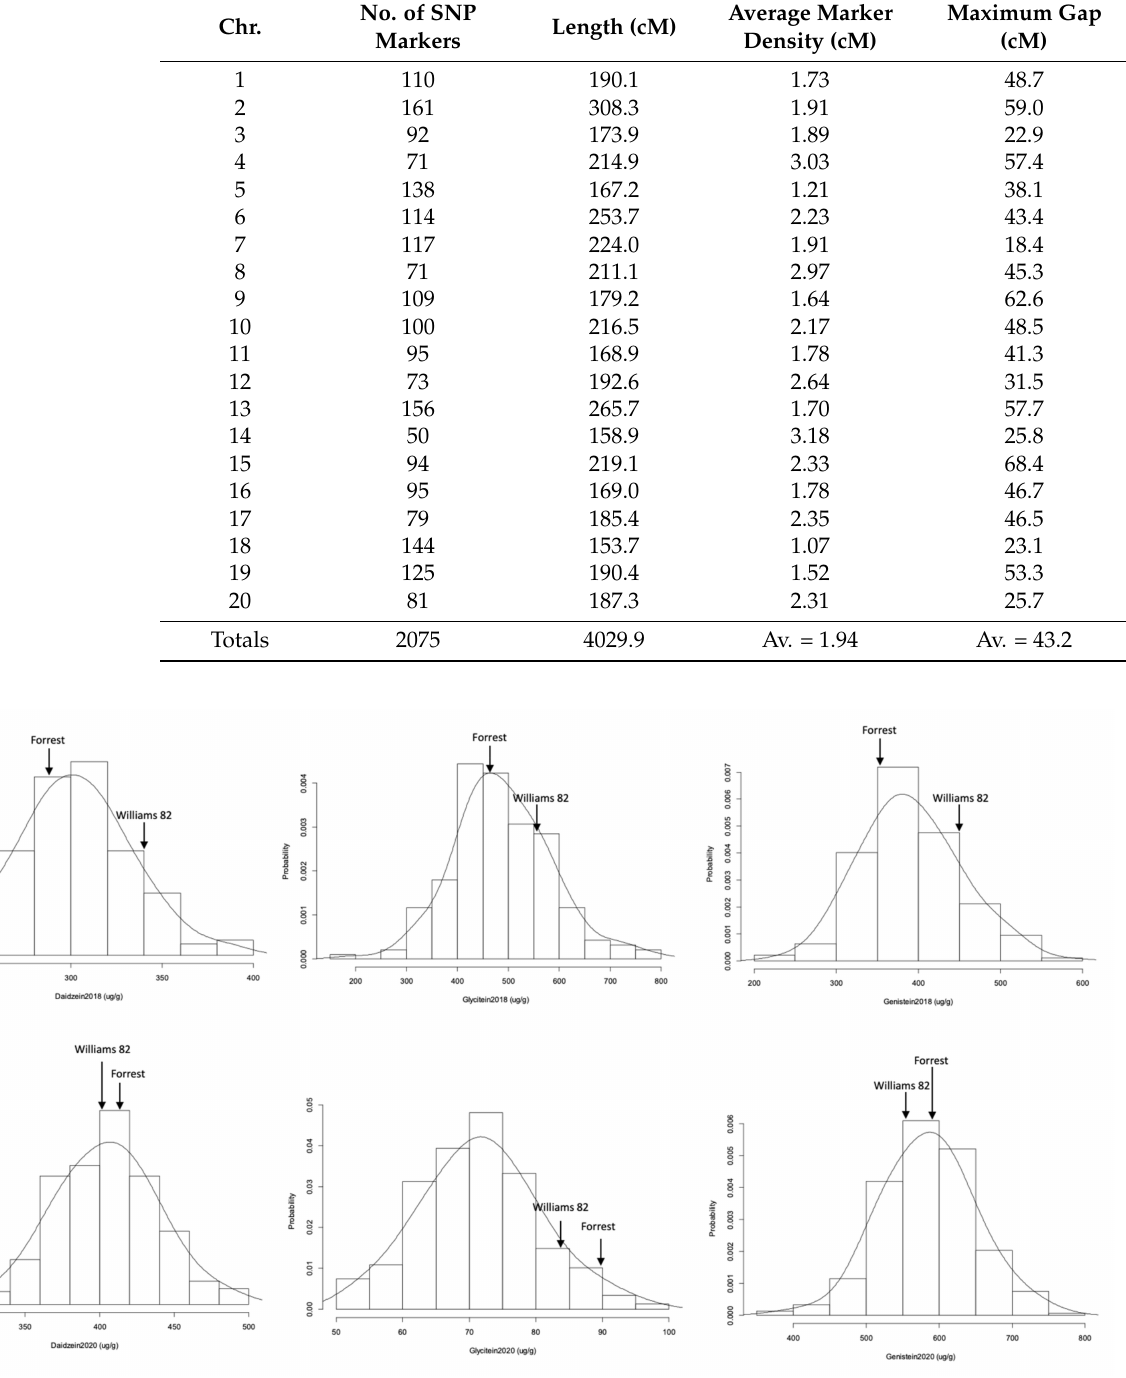
Figure 1. Frequency distribution of seed isoflavone contents ( µ g/g of seed weight) in the FxW82 RIL population. The seed daidzein, genistein, and glycitein contents were assessed in the RILs harvested in Spring Lake, NC (2018) and Carbondale, IL